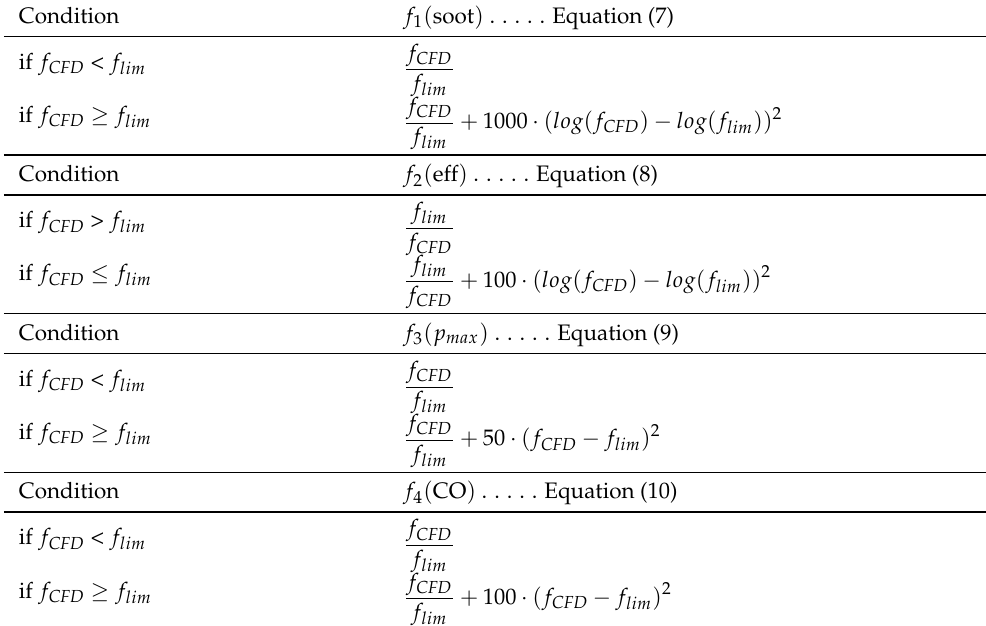
Table 7. Component functions of the parameters to optimize and the constraints.